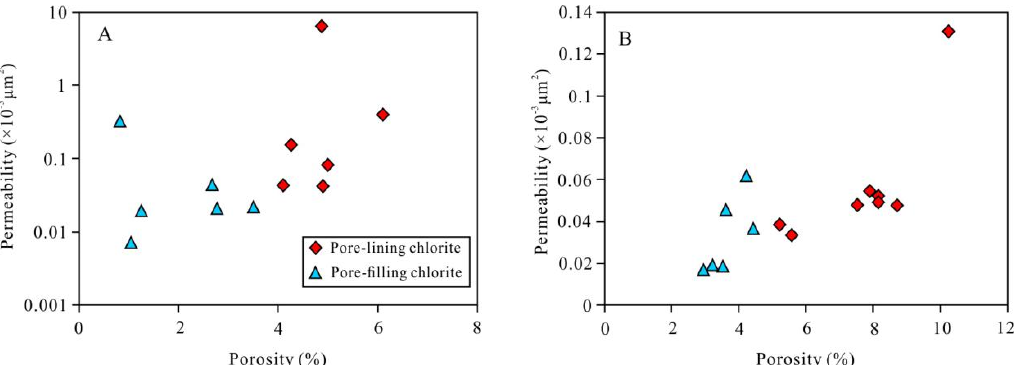
Figure 12. Relationship between porosity and permeability of chlorite in different occurrences: ( A ) well Bei 210 and ( B ) well Bei 202.